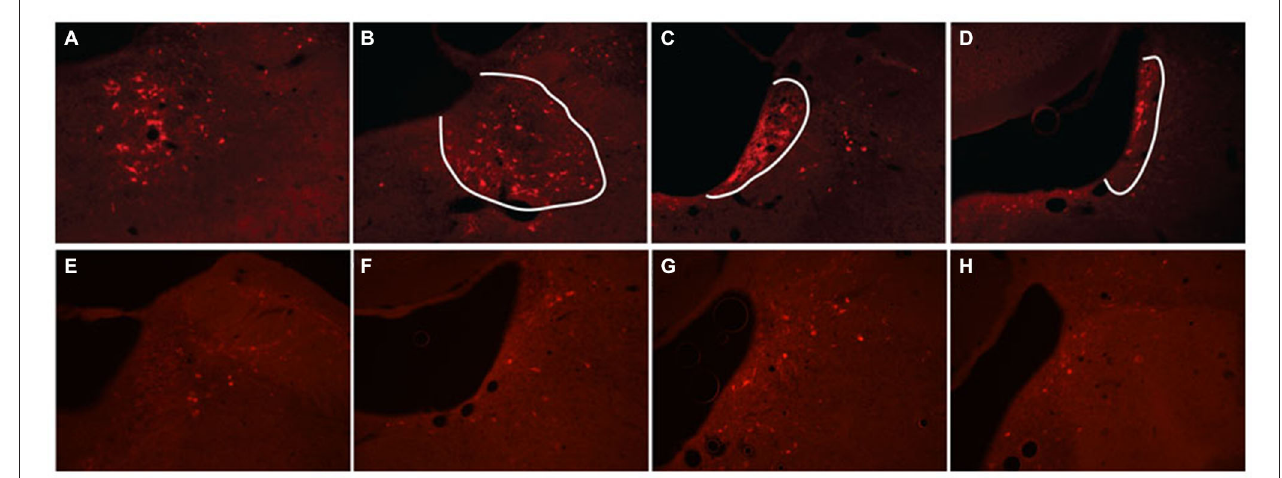
fluorescence indicating hM3Dq receptor expression. The approximate area of the LC is outlined in white in (A–D) to illustrate expression primarily restricted to LC neurons.